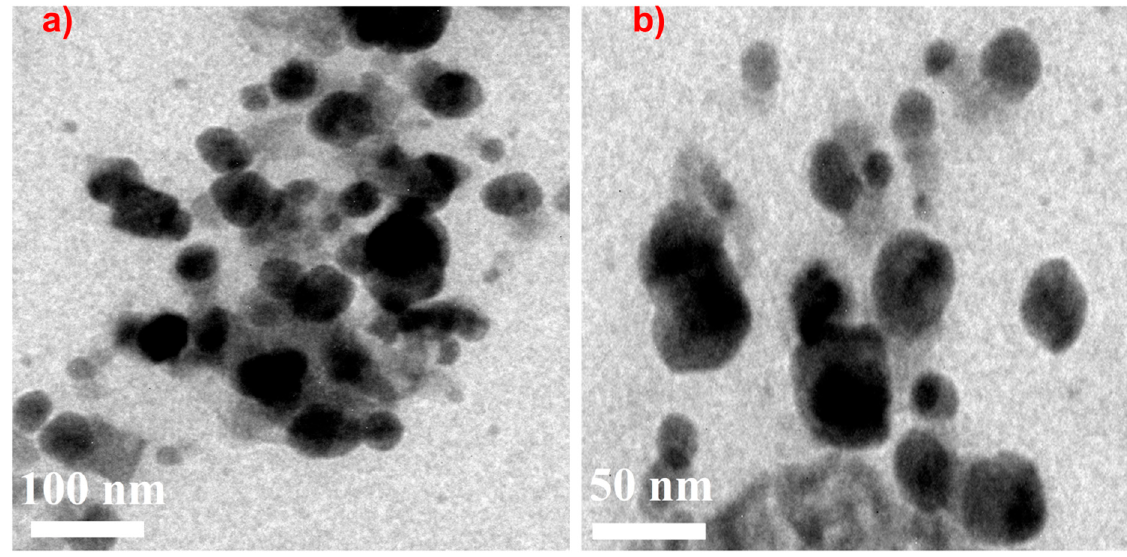
Figure 5. ( a , b ) TEM images of green synthesized NiSe NPs.